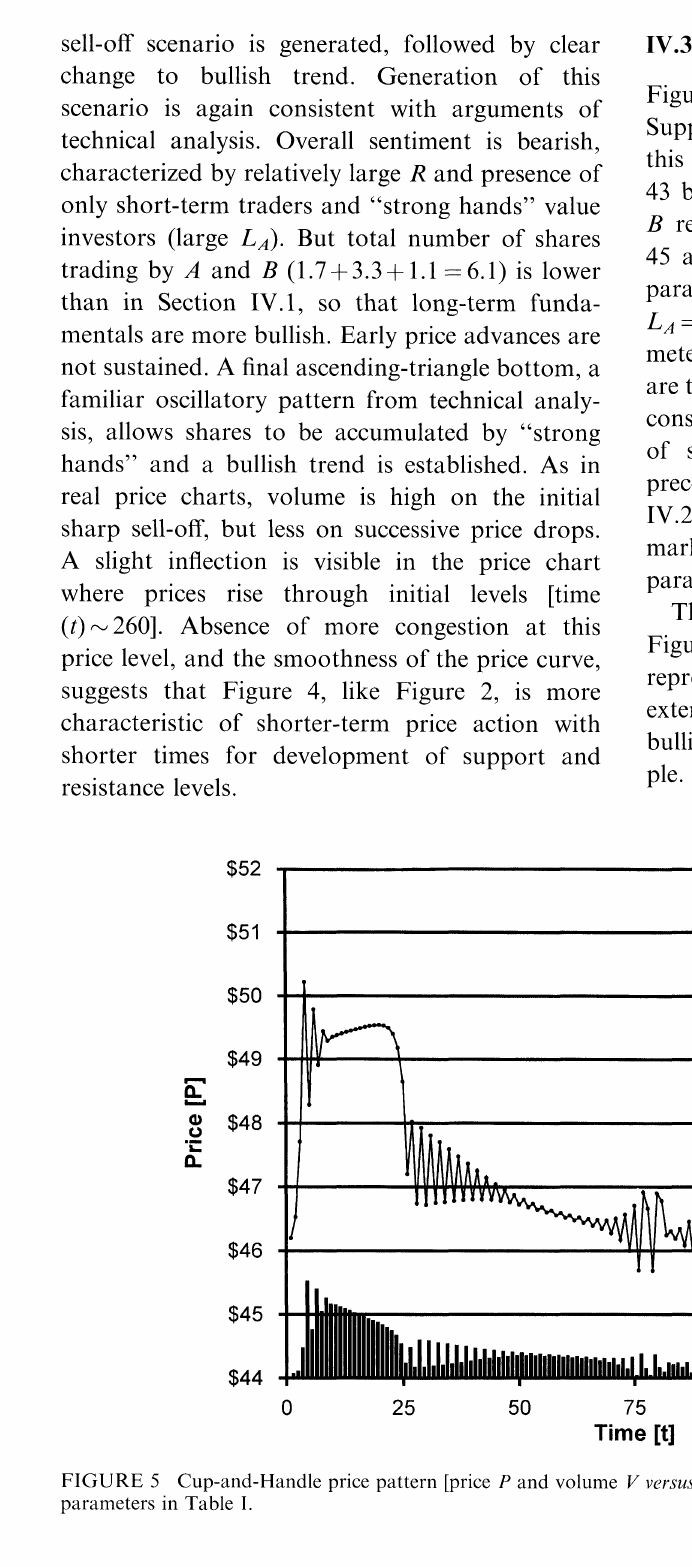
FIGURE 5 Cup-and-Handle price pattern [price P and volume V versus time t] generated from Eqs. (1)-(5) and indicated initial parameters in Table